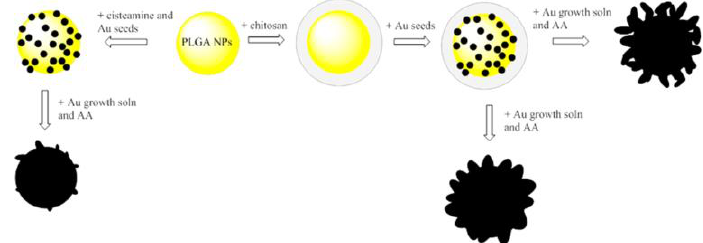
Figure 20. Control of anisotropy on branched gold nanoshells using chitosan or cysteamine as binding linkers for gold seeds. Reprinted with permission from Reference [126]. Copyright (2014) American Chemical Society.